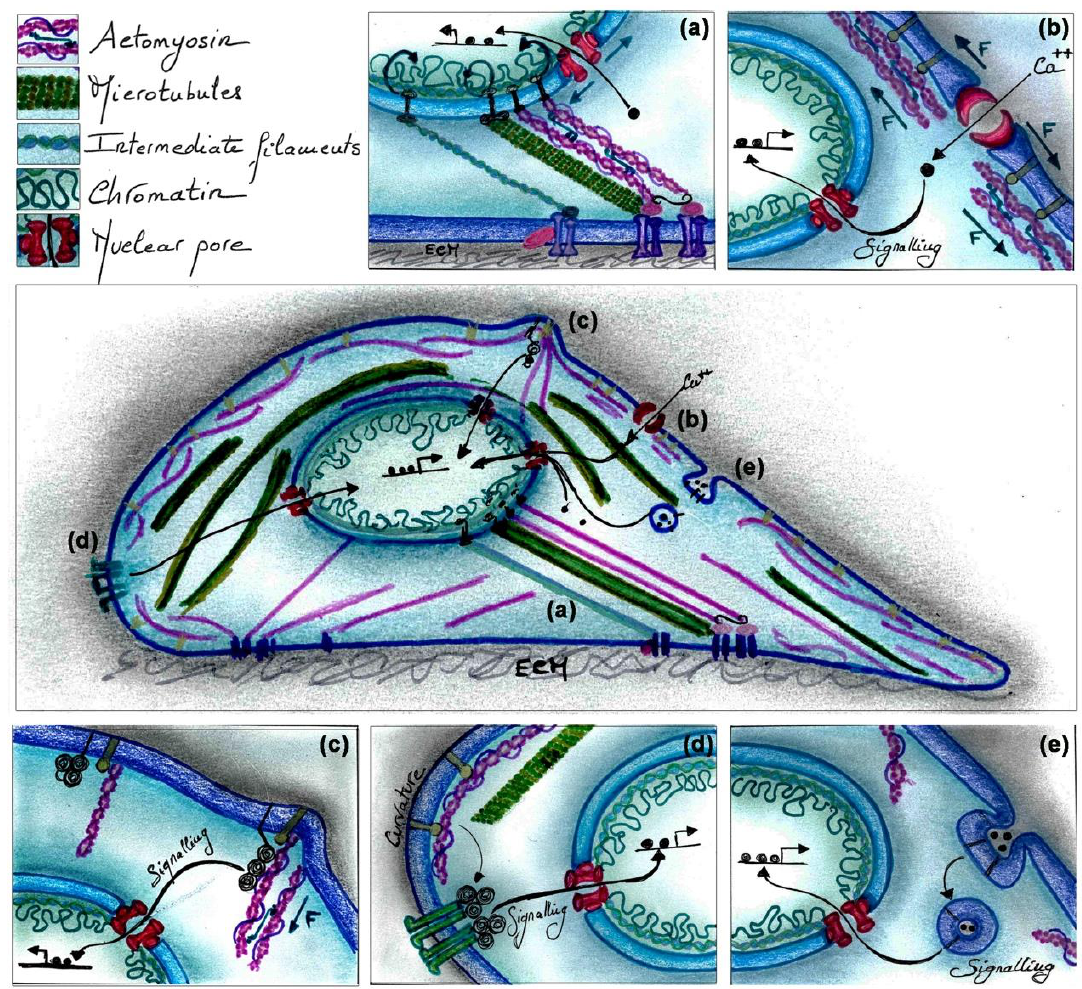
Figure 1. Examples of mechanisms by which cell shape regulates gene transcription. ( a ) Forces transmitted from the cell surface to the nuclear envelope through MFs, MTs or IFs can alter chromatin organization, the accessibility of transcription and other chromatin regulatory factors, as well as stretch nuclear pores to facilitate the transport of molecules. ( b ) Alteration of surface tension, bending of the membrane or forces applied on F-actin beneath the plasma membrane can mechanically activate calcium channels. ( c ) Stretching of the membrane can also induce tension on actomyosin, which can unfold proteins, exposing their substrate sites and induce signalling to the nucleus. ( d ) Cell shape-dependent alterations of the membrane and of the actin cytoskeleton can alter lipid raft micro-domains within the plasma membrane and activate signalling pathways. ( e ) Shape-dependent alteration of cell surface tension can activate signalling pathways by stimulating the rate of endocytosis.